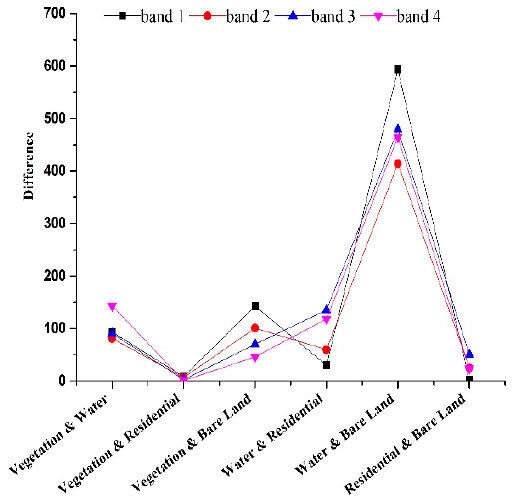
Figure 7. Comparison of differences in the mean grey value of each band for land cover types.